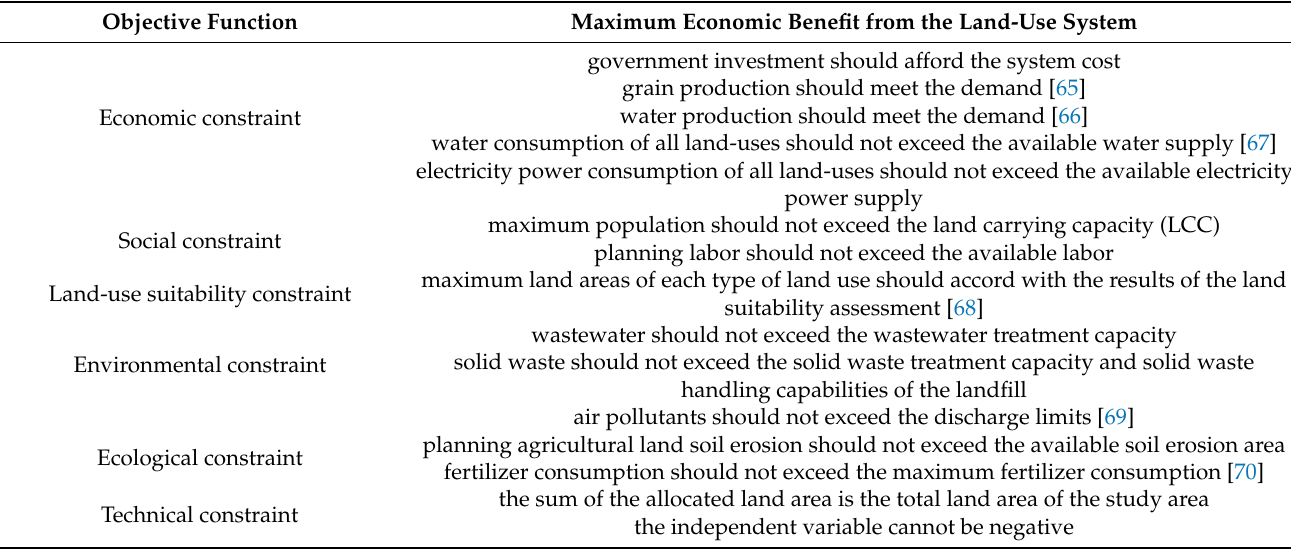
Table 1. Description of the